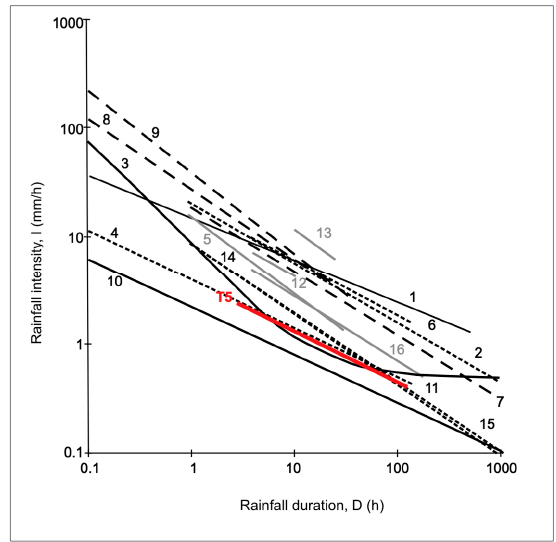
Figure 9. Comparison between the ID threshold established for the Portofino promontory and threshold curves available in the literature for the possible initiation of shallow landslides in Italy and worldwide (Table 4). The red curve is the new threshold obtained in the present work. Black curves represent global thresholds, dotted and broken black curves portray local and regional thresholds, respectively, grey curves symbolize thresholds defined for single catchments.